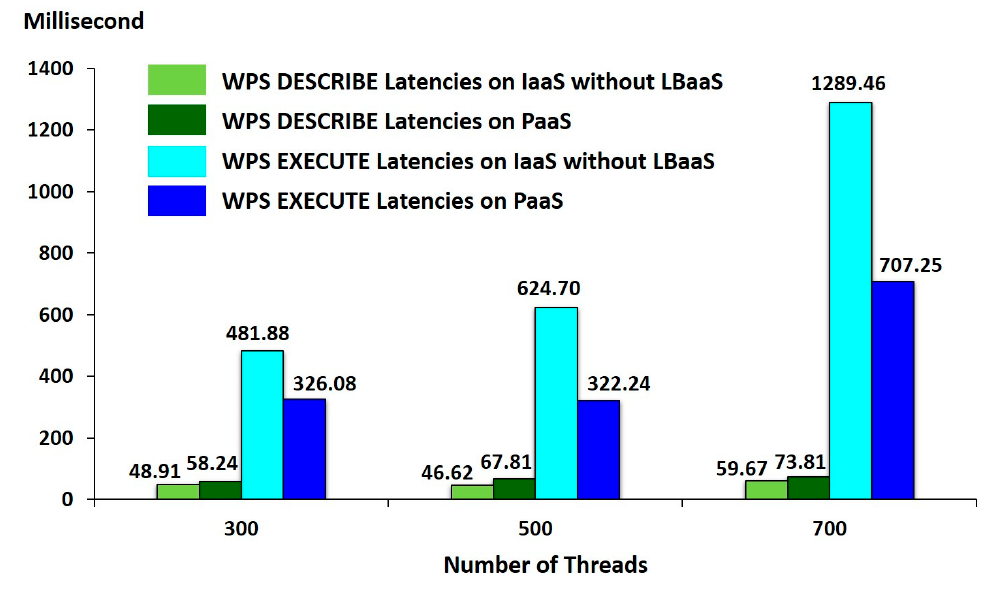
Figure 7. Performance test summary of OGC WPS 2 execute and describe operations with an edge detection algorithm for PaaS and IaaS without LBaaS.